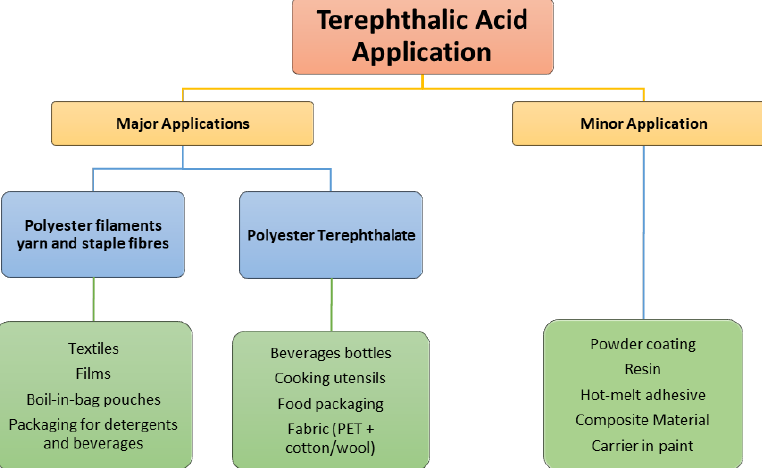
Figure 1. Applications of terephthalic acid (1,4-benzenedicarboxylic acid, TPA). Adapted from [1]. The current worldwide purified terephthalic acid market was evaluated to be between USD 51.5 and 54.8 billion in 2021, and is estimated to reach USD 70 or 78 billion at the end of the decade [2–4]. This would represent a compound annual growth rate of